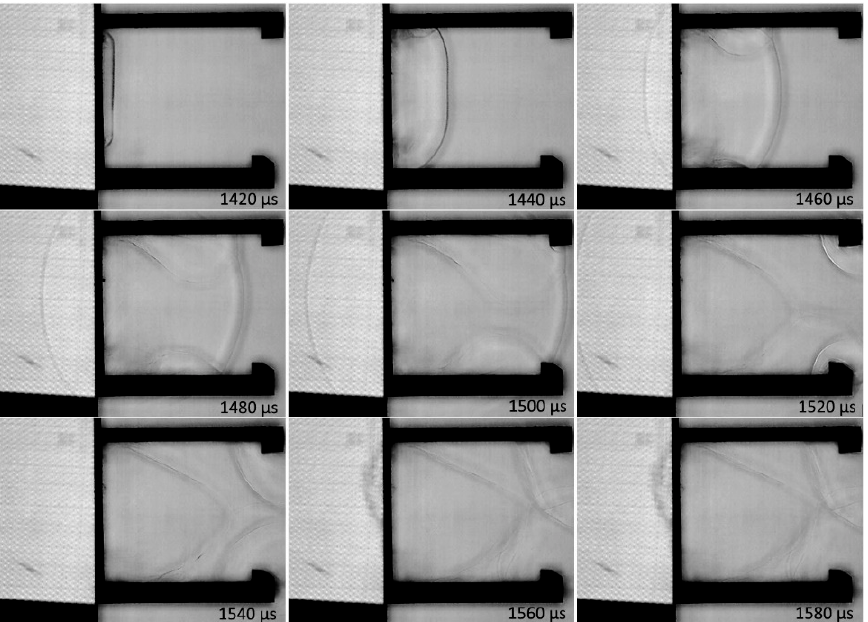
Figure 9. Photographic results of high-speed video recording, showing shock wave propagation at the outlet of the EDST (20 µs between each photograph).